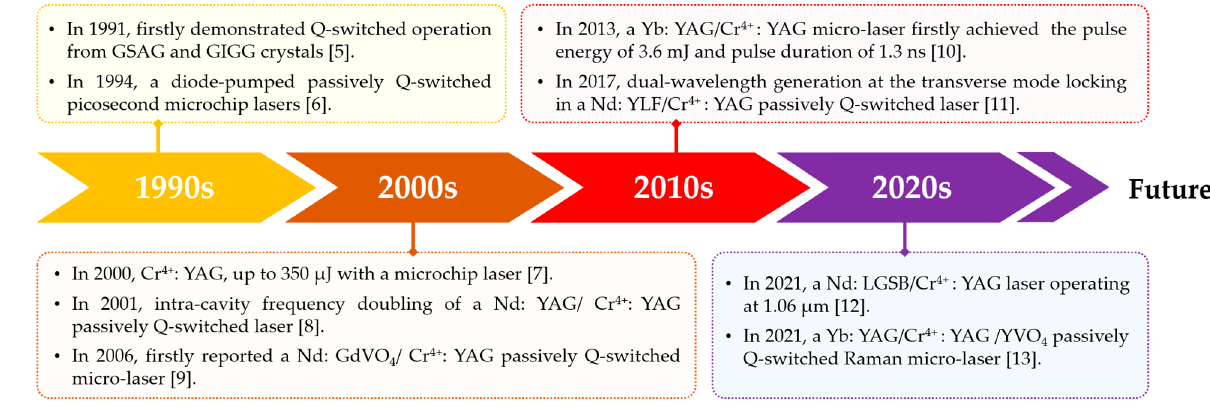
Figure 2. Timeline of advances in all-solid-state passively Q-switched lasers based on Cr 4+ -doped crystals [5–13].